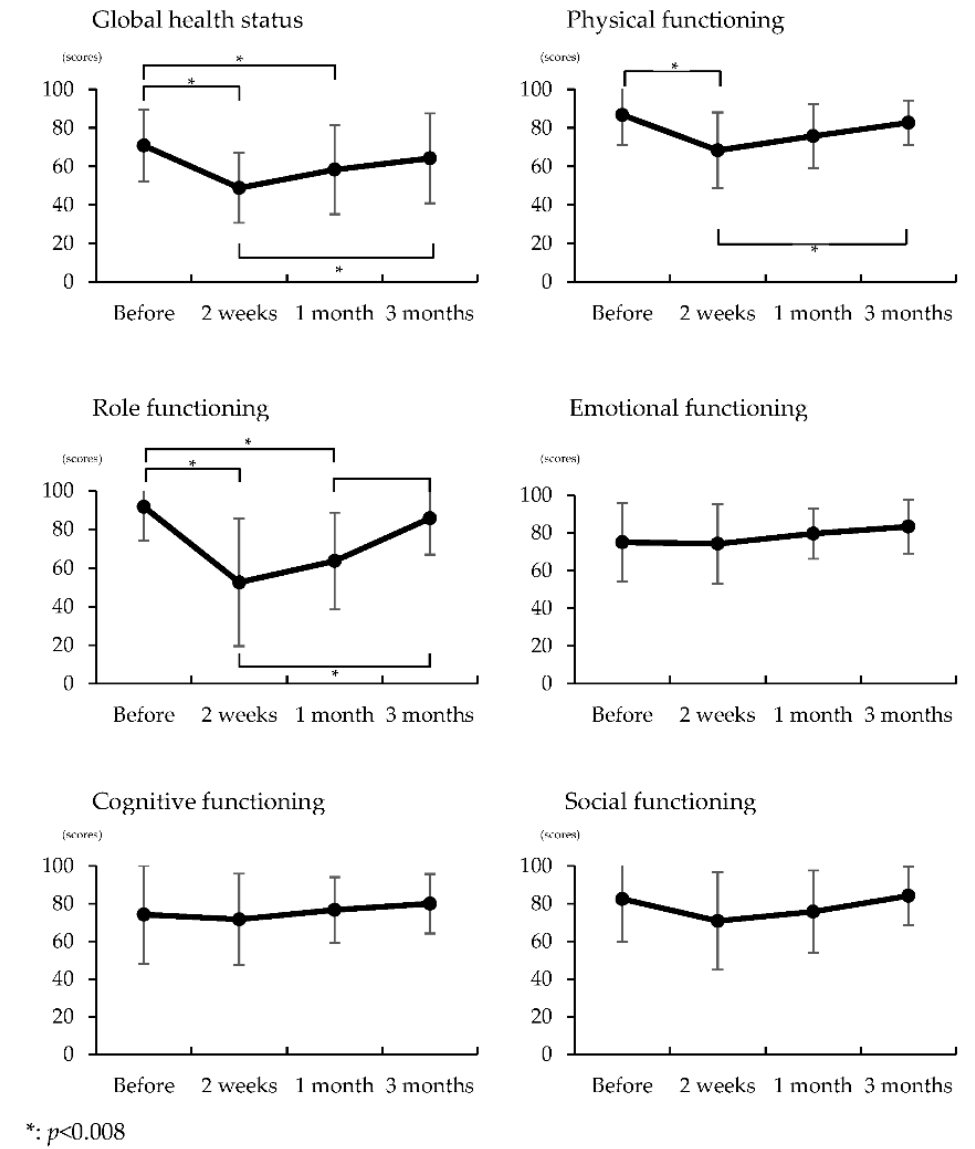
Figure 2. Comparisons of quality of life at before, two weeks, one month, and three months after surgery.